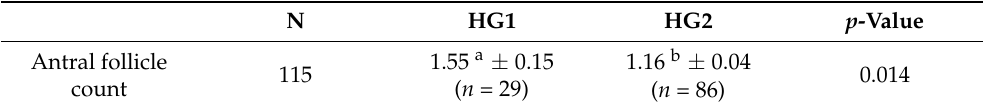
Table 2. Association analysis of antral follicle count with different